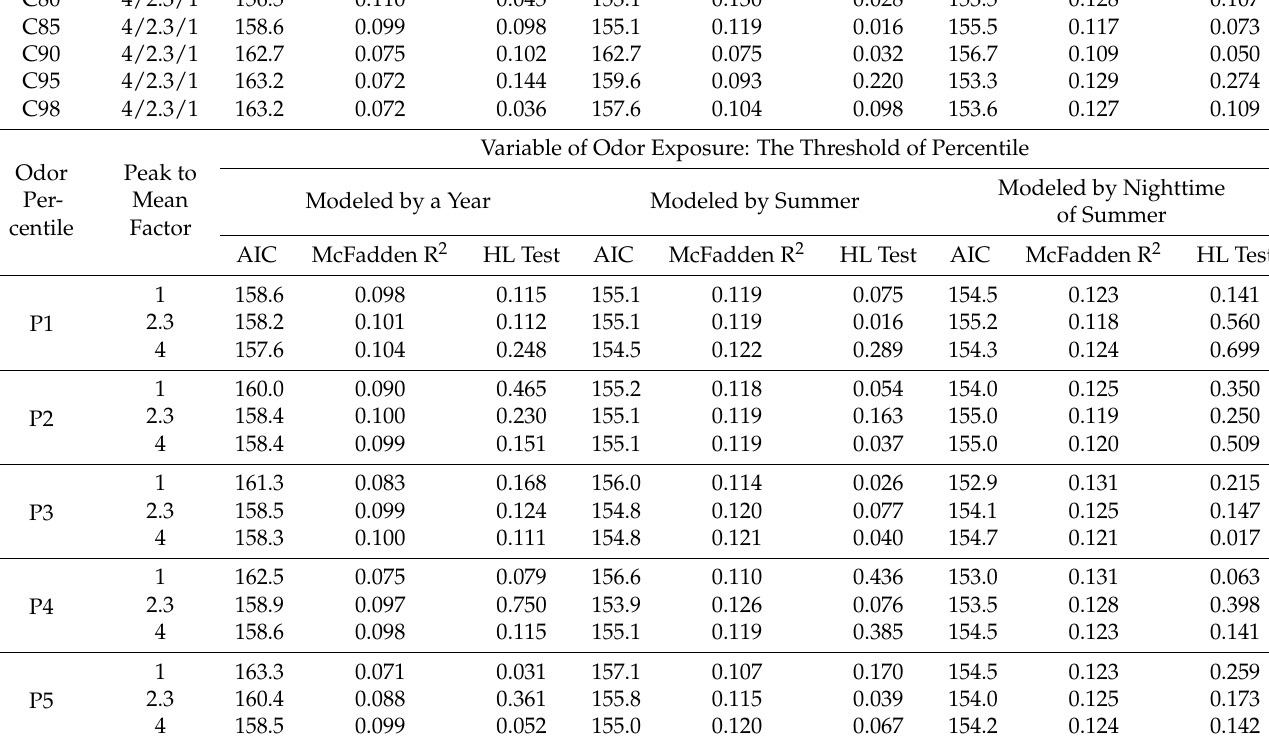
Table 4. Predictive ability (accuracy, AUC) for odor annoyance by binomial logistic regression models a .